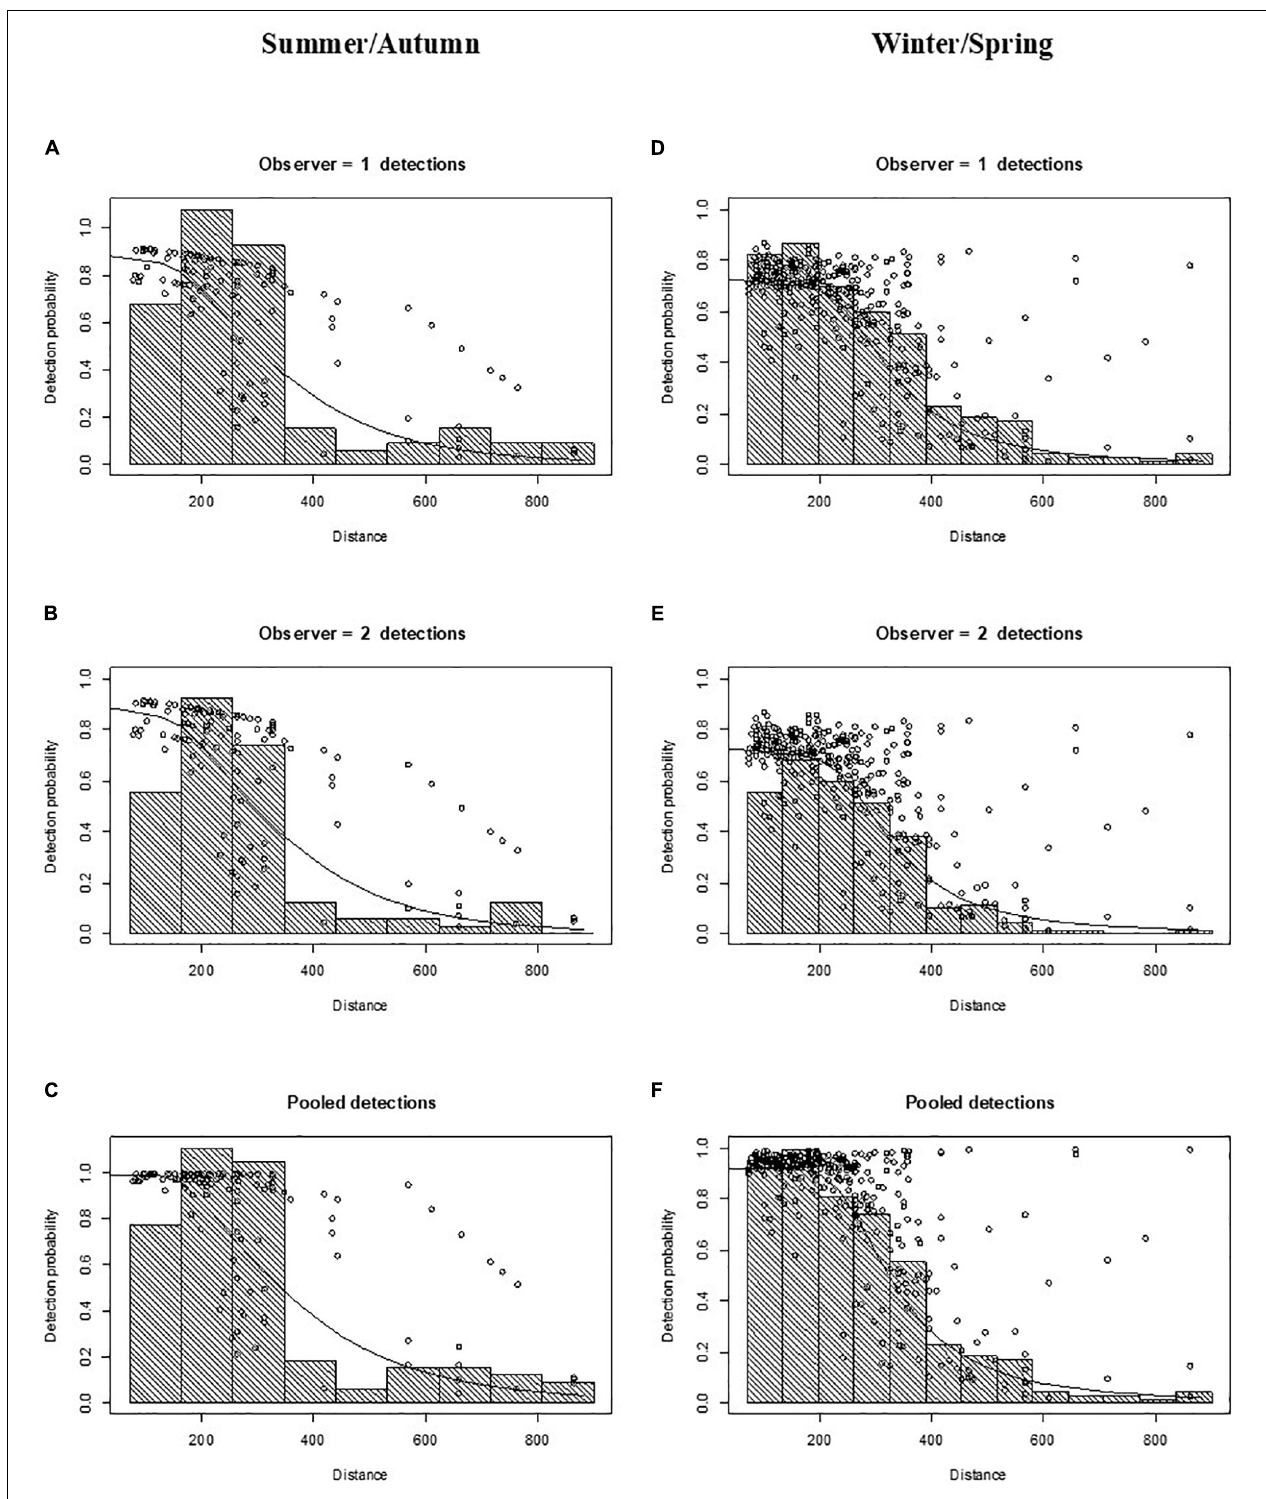
FIGURE 3 | Detection function plots for the 2011 aerial survey of common dolphins ( Delphinus delphis ) in central South Australia in summer/autumn (A–C) and winter/spring (D–F) . Points (circles) are the probability of detection for each sighting given its perpendicular distance and other covariate values. Lines are the fitted models. (A,D) Observer 1 detections (mid-seat observers); (B,E) observer 2 detections (rear-seat observers); and (C,F) pooled detections. Data were left truncated at 71 m (to adjust for obstructed view of the transect line) and right truncated at 900 m (to remove outliers at long